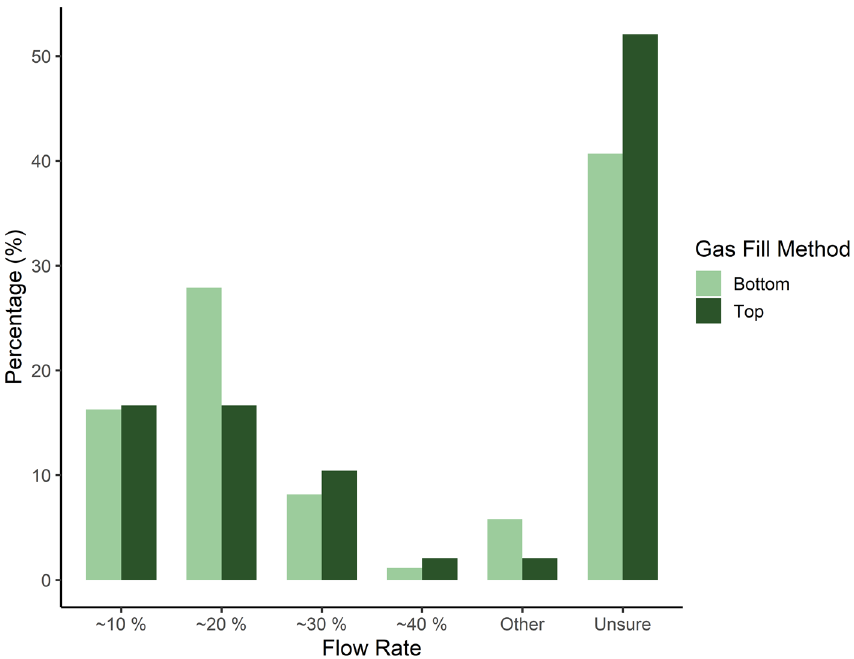
Figure 3. Percentage (%) of 172 participants reporting usage of different flow rates (as a percentage of the total chamber volume per minute) according to gas fill method (carbon dioxide (CO 2 ) gas delivered to either the top or the bottom of the chamber) during operation of exposure to CO 2 as a Schedule 1 killing method for adult (non-foetal) laboratory rodents.